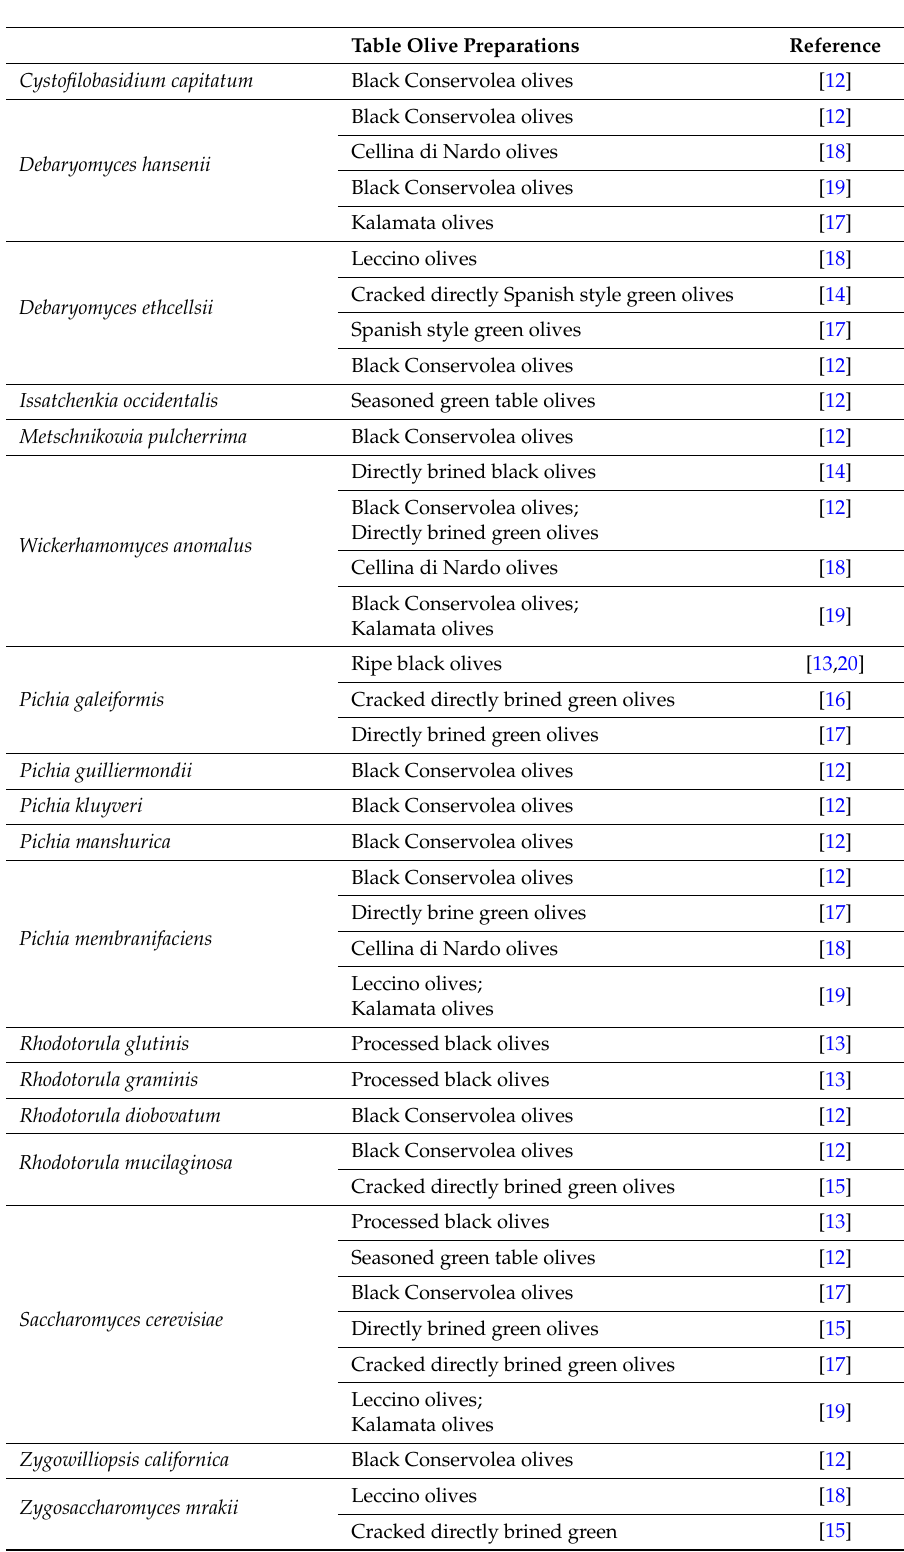
Table 1. Cont . Table Olive